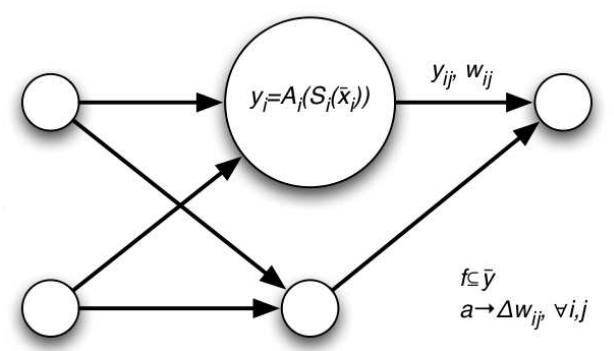
Figure 1. Schematic of an ANN instantiation of a CN. Nodes have a function y i that is computed from its inputs ( x i ). Edges have weights w ij to determine the importance of the interaction and also carry the output of neurons and network inputs. The network function f or output is given by a subset of node functions y . The algorithm a changes weights on edges.